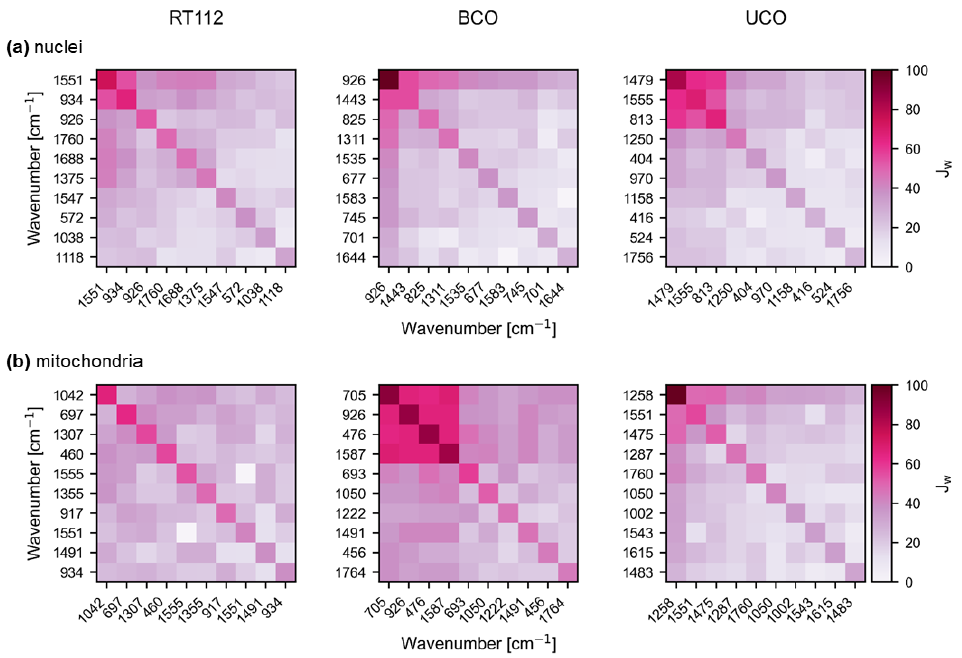
Figure 4. Weighted Jaccard coefficients for the most important wavenumbers evaluated with FeaSel-Net in percent. The plots describe the dependencies within the selected wavenumbers. Darker areas indicate a strong relationship between the features. The selection dependency for the nuclei spectra of each organoid type is shown in ( a ), whereas those of mitochondria are depicted in ( b ).